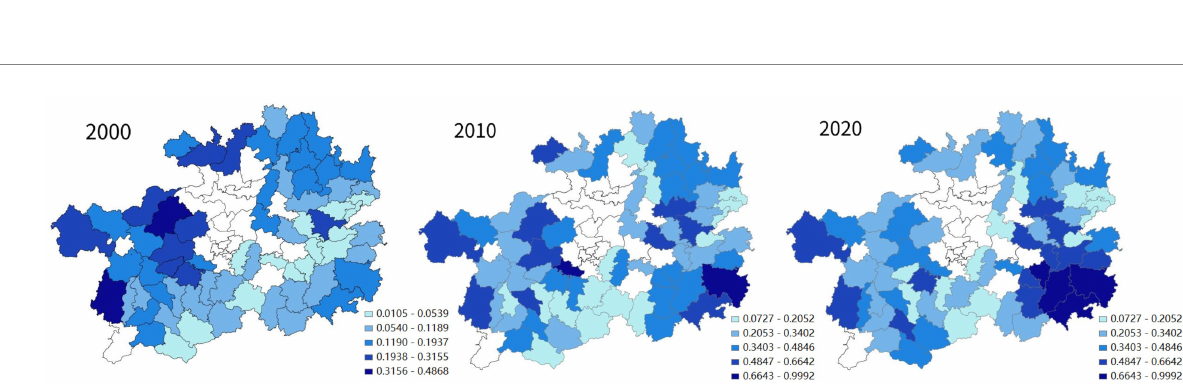
quality of cultural life were still mostly in its western part, Liping County in the southeast topped this list. By 2020, the districts and counties with high cultural QoL in Guizhou had been completely